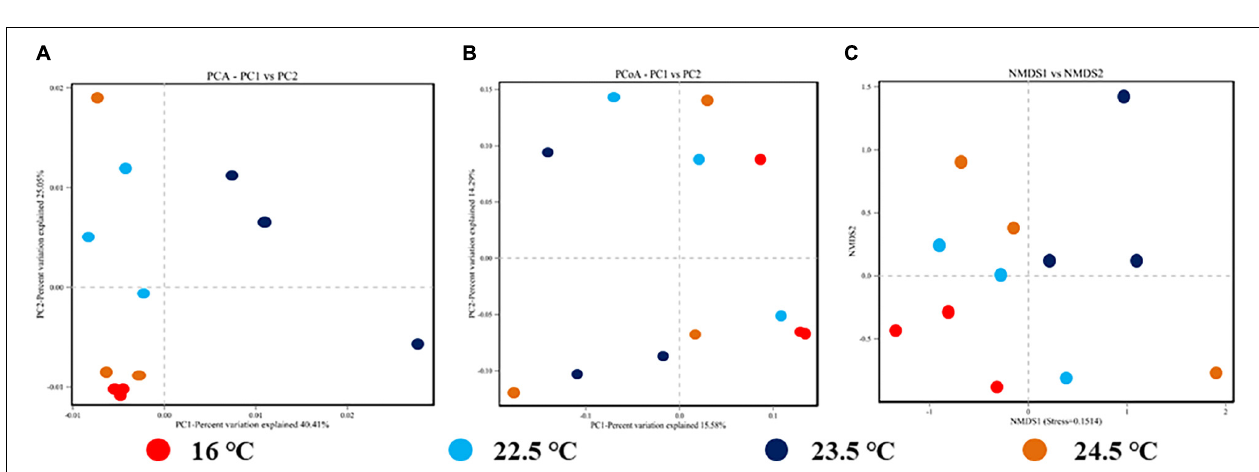
FIGURE 4 | Beta diversity analysis of intestinal microbiome for each sample in different temperature stress groups. (A) OTUs-based PCA plot; (B) Unweighted Unifrac distance-based PCoA plot; (C) Binary-Jaccard distance-based NMDS plot.